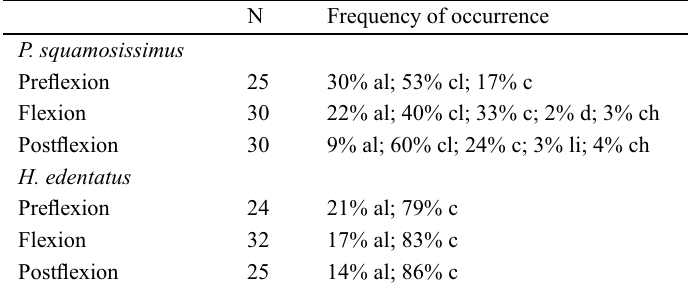
Number of P. squamosissimus and H. edentatus stomachs analyzed (N), and the frequency of occurrence of food items in diet separated by developmental stages (al – algae; c – copepods;